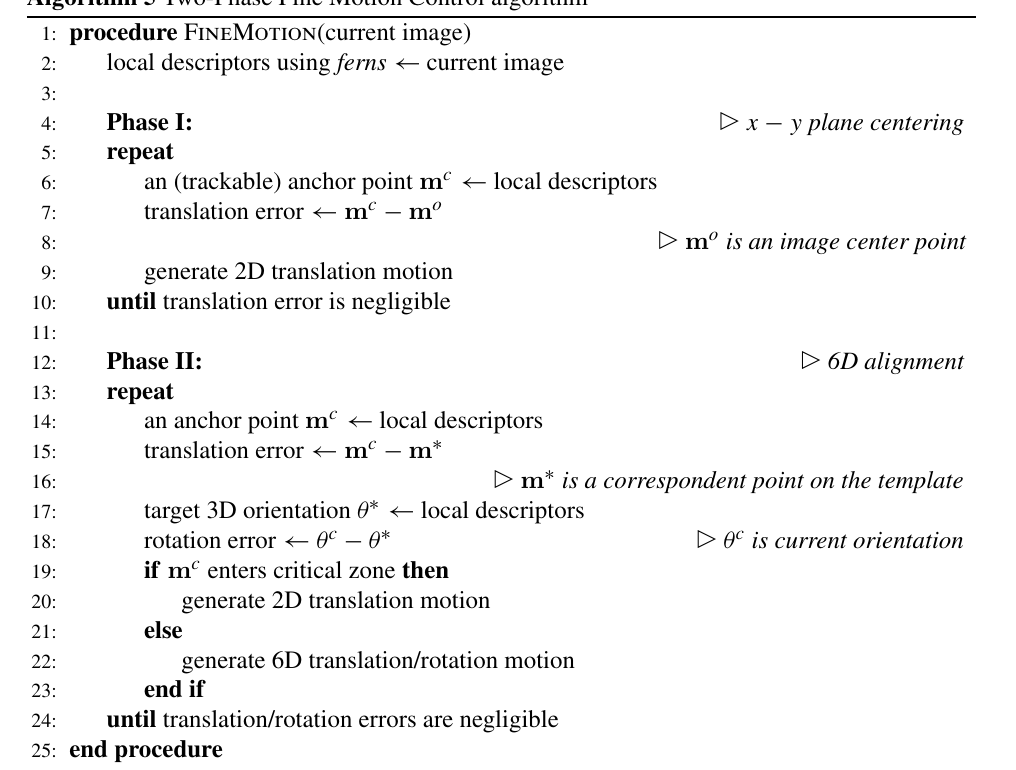
Algorithm 5 Two-Phase Fine Motion Control